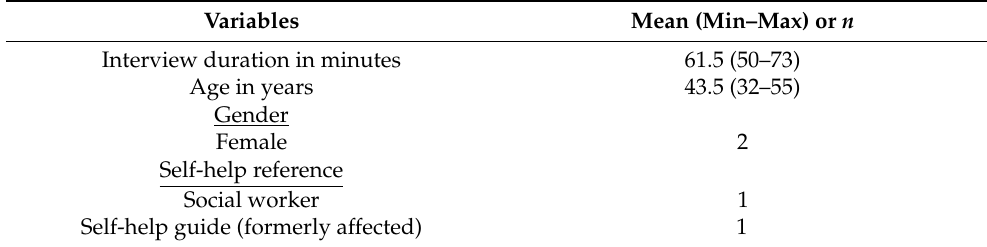
Table 2. Sample characteristics of the self-help experts ( n =